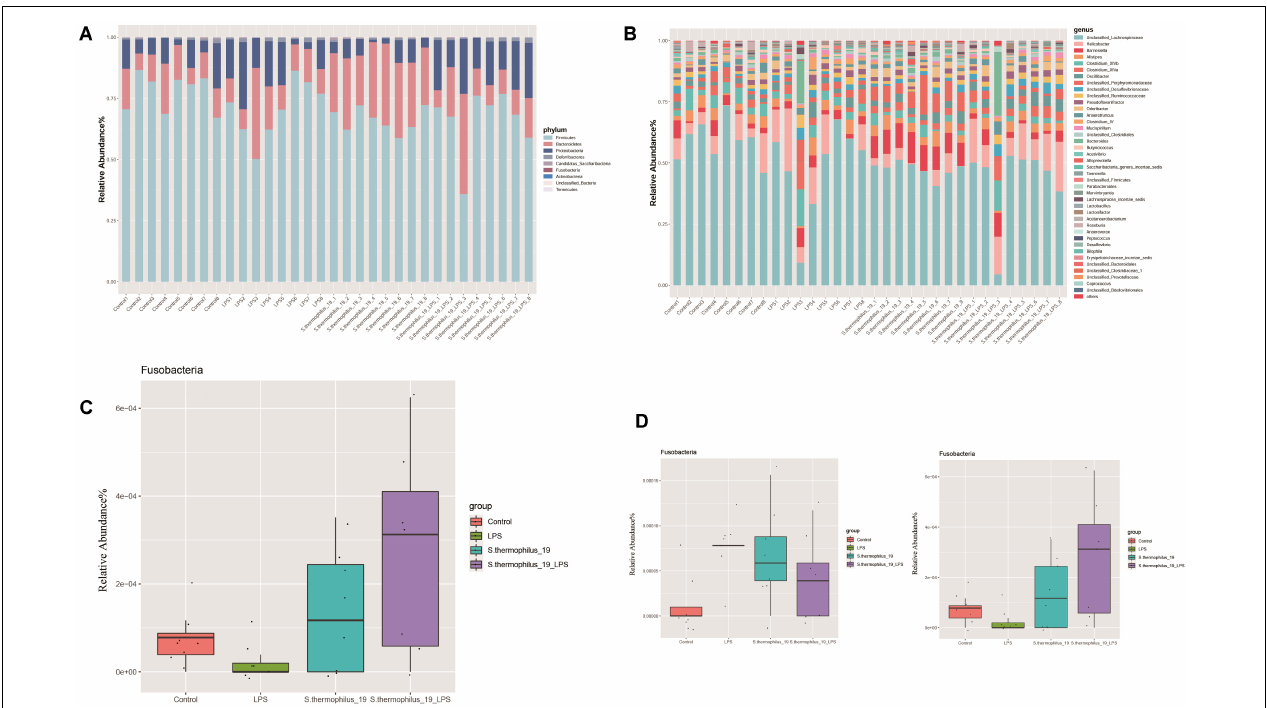
FIGURE 5 | S. thermophilus 19 has a significant impact on microbiota composition ( n = 8). (A) The change of gut microbiota at phylum level. (B) The change of gut microbiota at genus level. (C) The details of the change of Fusobacteria in different groups. (D) The details of the change of Flavonifractor and Fusobacterium in different